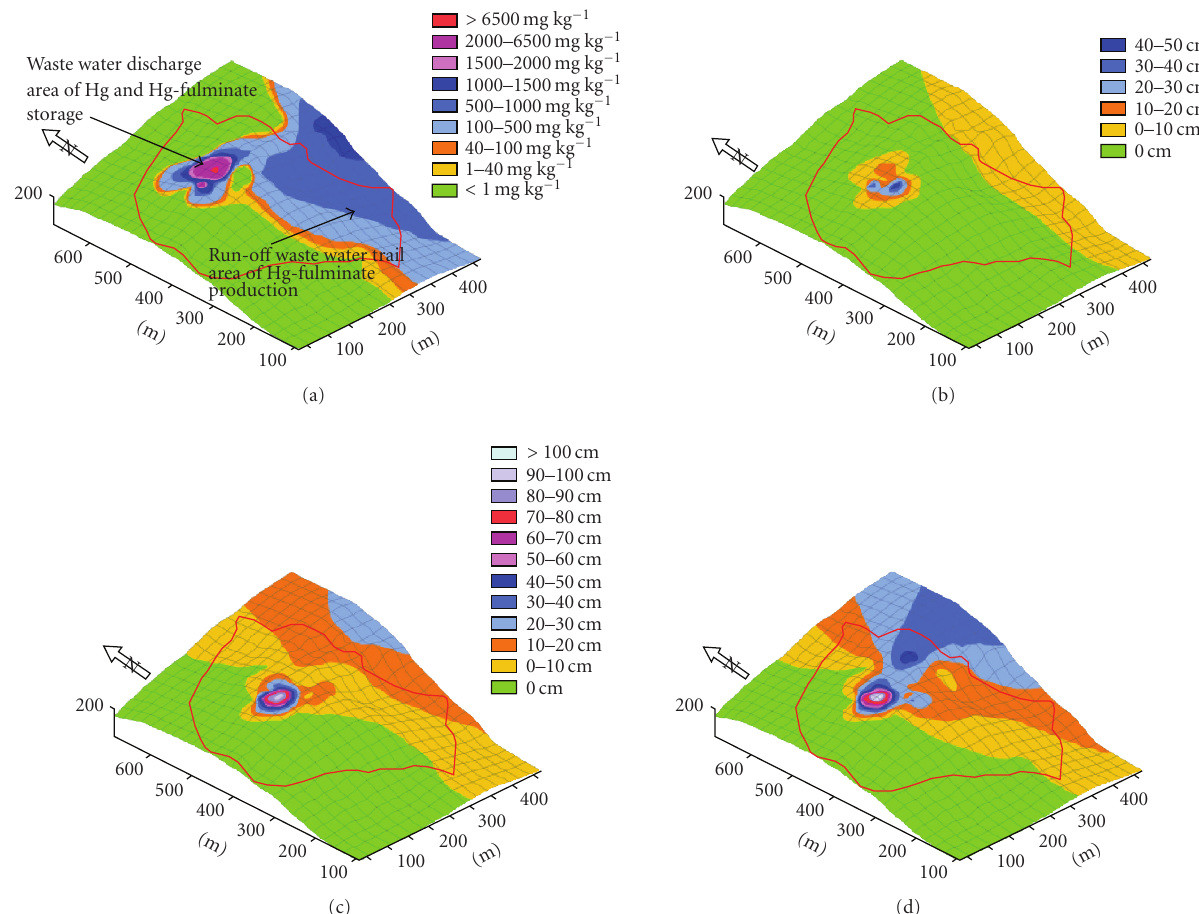
Figure 2: Digital maps of Hg distribution in the soils of the area around the Hg-fulminate facilities. (a) Surface Hg concentrations, (b), (c), and (d) depths to which Hg concentrations reached values above 1, 0.1, and 0 . 04gkg − 1 ,